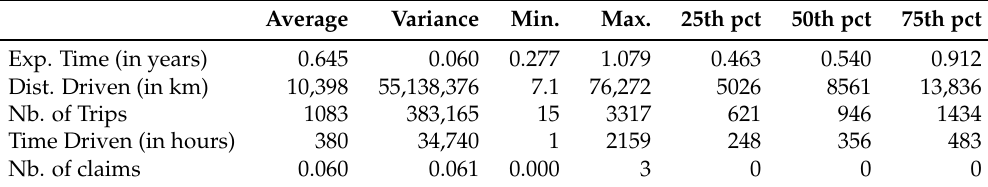
Table 2. Descriptive statistics for a single insured period.